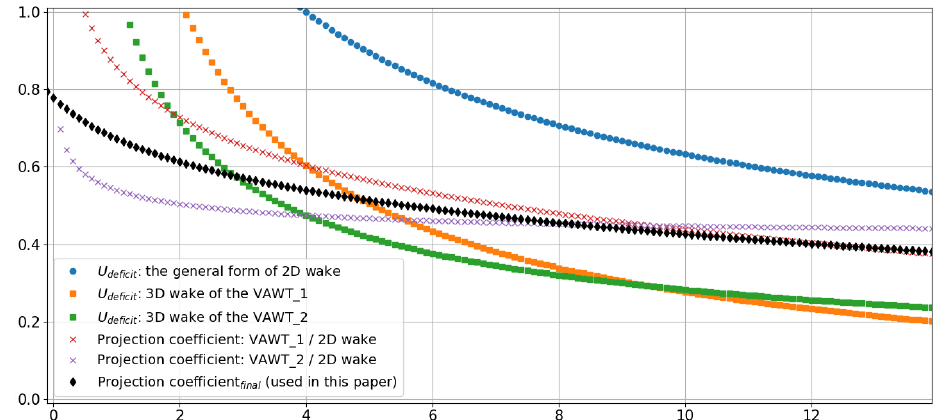
Figure 6. The correction coefficient along the streamwise direction. The X-axis is the downstream position normalized by the rotor diameter ( X/D ). The Y-axis represents two normalized parameters; one is the normalized velocity deficit Δ U/U 0 (symbol ● and ■ ) of the wake model, the other is the correction coefficient (symbol × and ♦ ) obtained by the division.